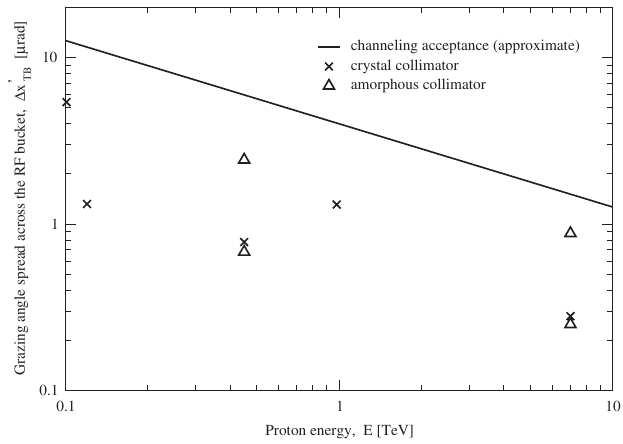
FIG. 5. Variation of the grazing angle spread across the rf bucket as a function of energy for amorphous and crystal primary collimators according to the data in Table I for RHIC, SPS, Tevatron, and LHC. The solid line maximum limit follows the inverse square root rule of thumb given by Eq. (85) for the primary collimator acceptance angle under crystal channeling. The grazing angle spreads appear to relatively safe, at least for nominal design optics without